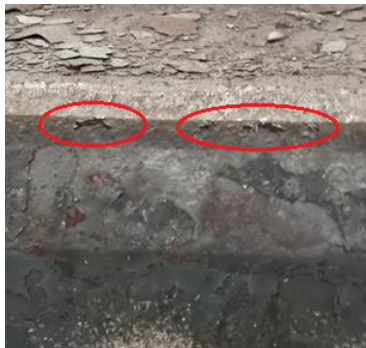
Figure 19. Small cracks on the slope face of a two-chamfered slab under horizontal rolling.